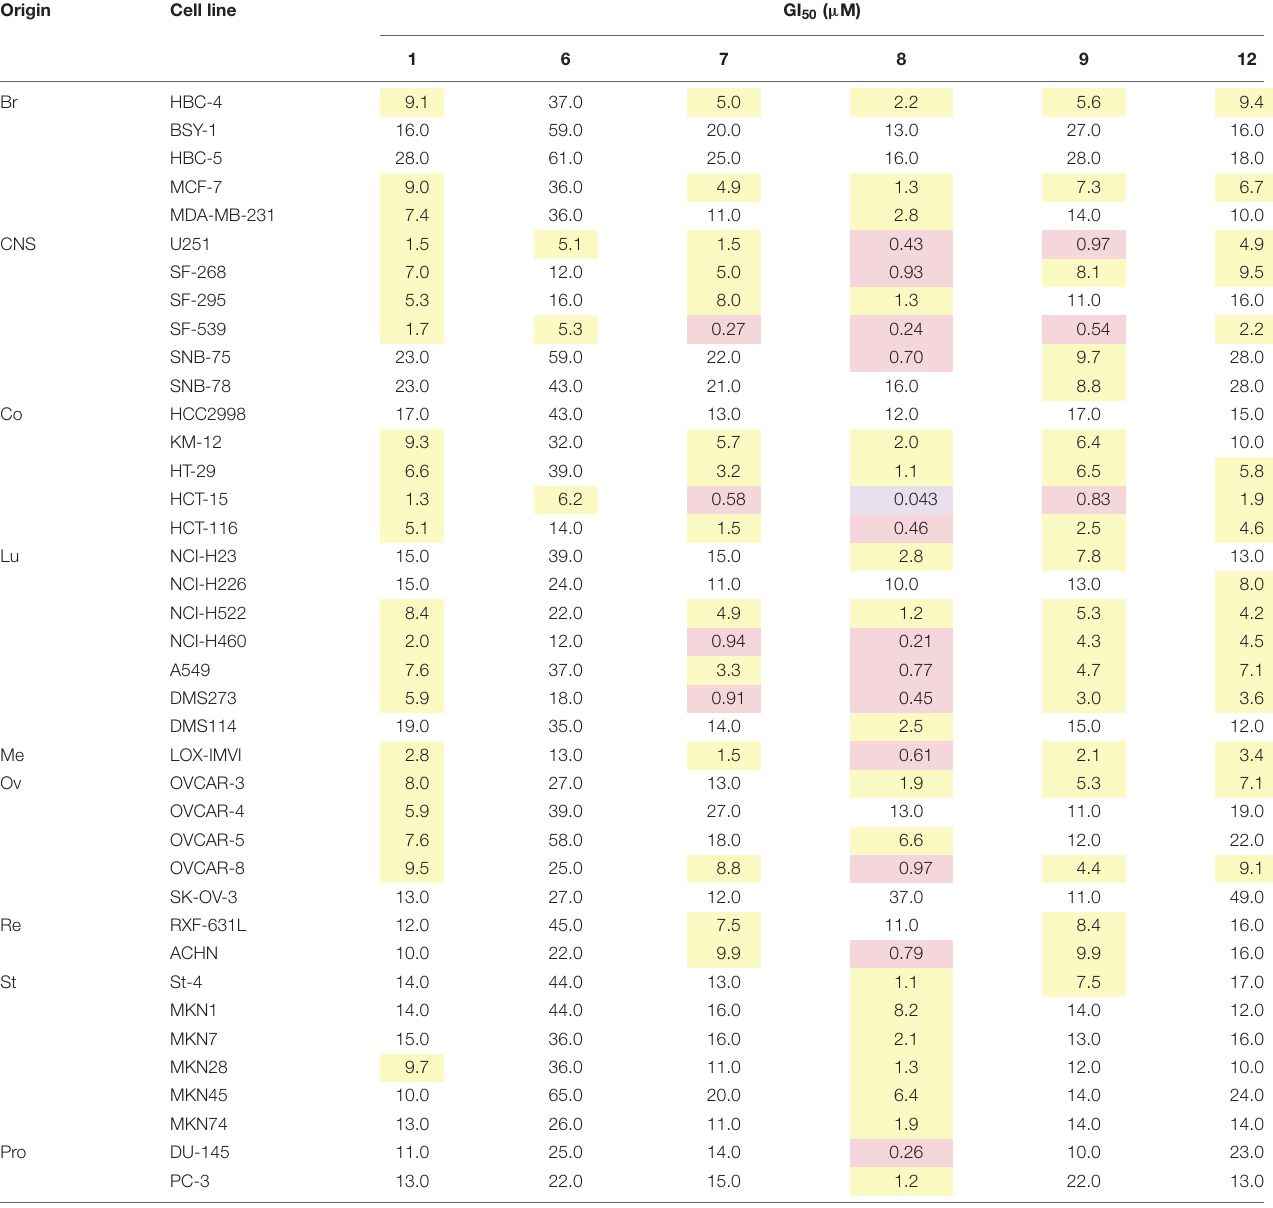
TABLE 4 | Effect of 1 and its derivatives on 39 types of human cancer cells.